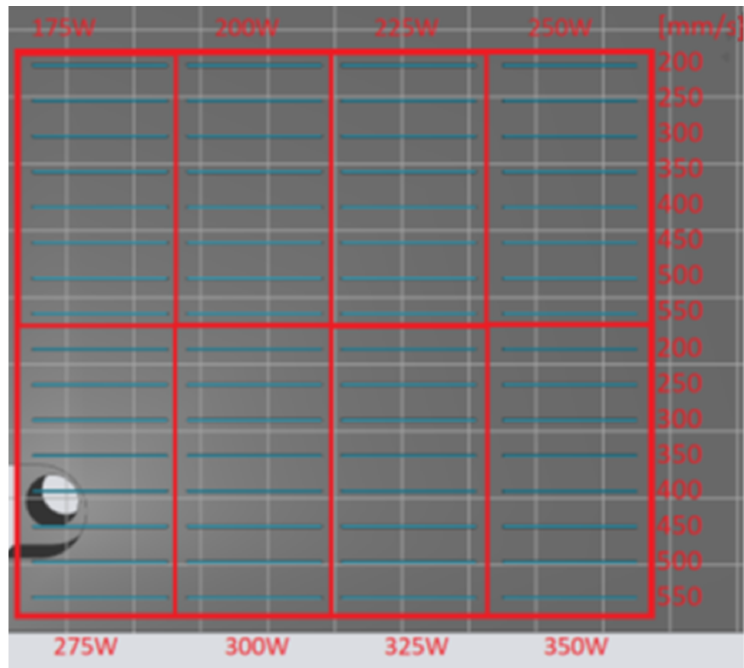
Figure 2. The layout of single tracks on the building platform.